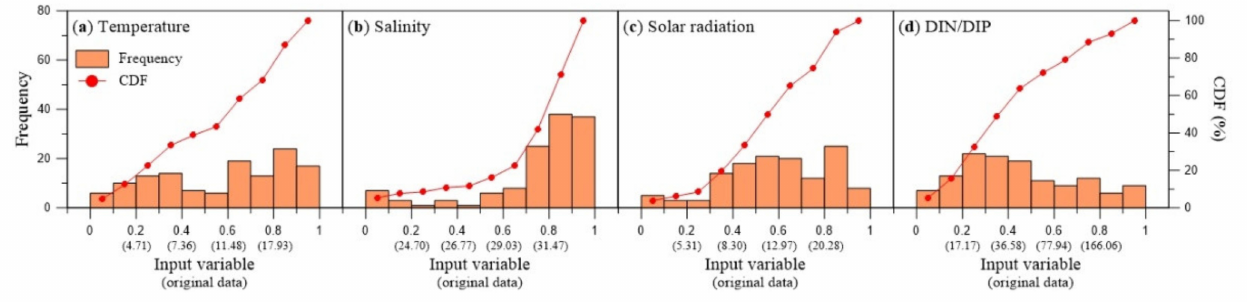
Figure 3. Histogram and cumulative distribution function (CDF) of original and transformed data for the input variables. ( a ) water temperature, ( b ) salinity, ( c ) solar radiation, ( d ) DIN/DIP